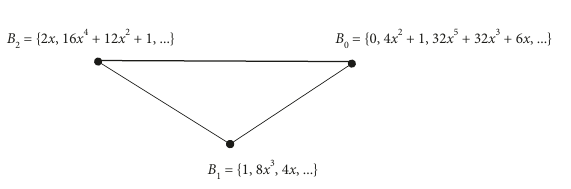
Figure 2: Pell polynomials kept at the endpoints of a